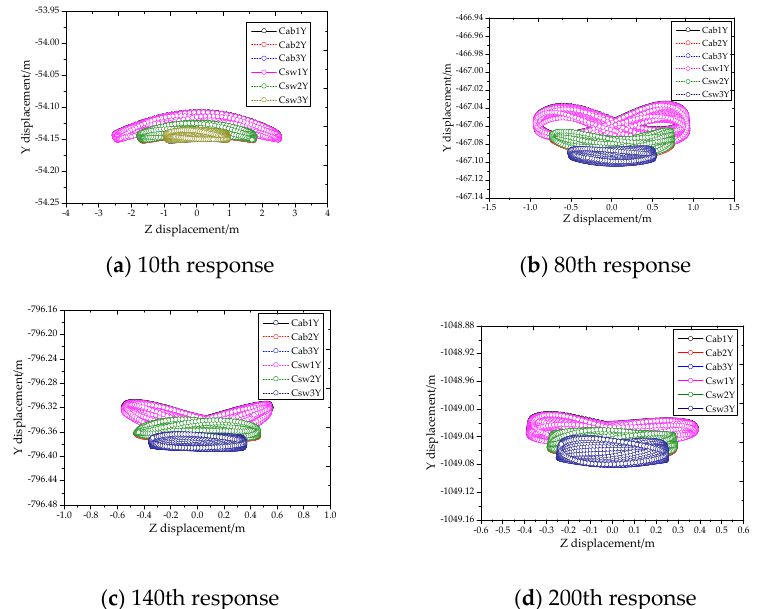
Figure 9. 10th – 200th two-dimensional response of a/no rigid body swing in the yz plane. Figure 9. 10th–200th two-dimensional response of a/no rigid body swing in the yz plane. Table 5. The location of Table 5. The location of nodes.